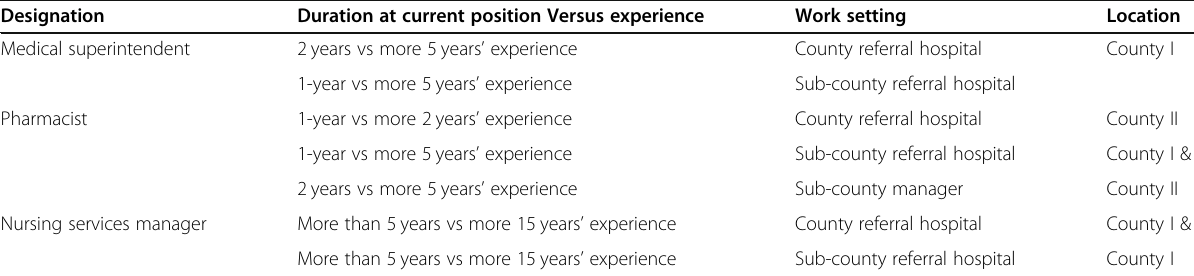
Table 1 Characteristics of